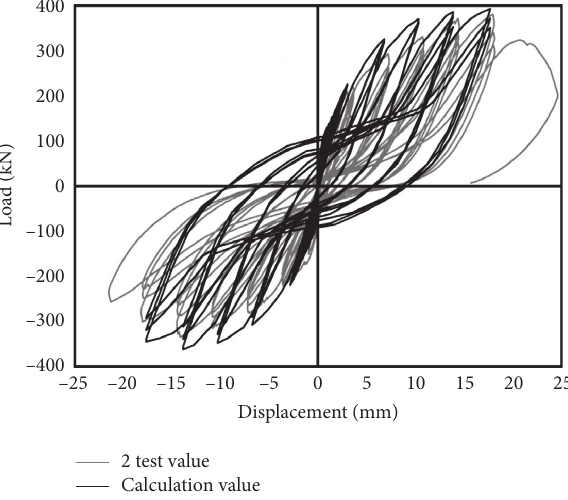
Figure 14: Comparison of hysteresis